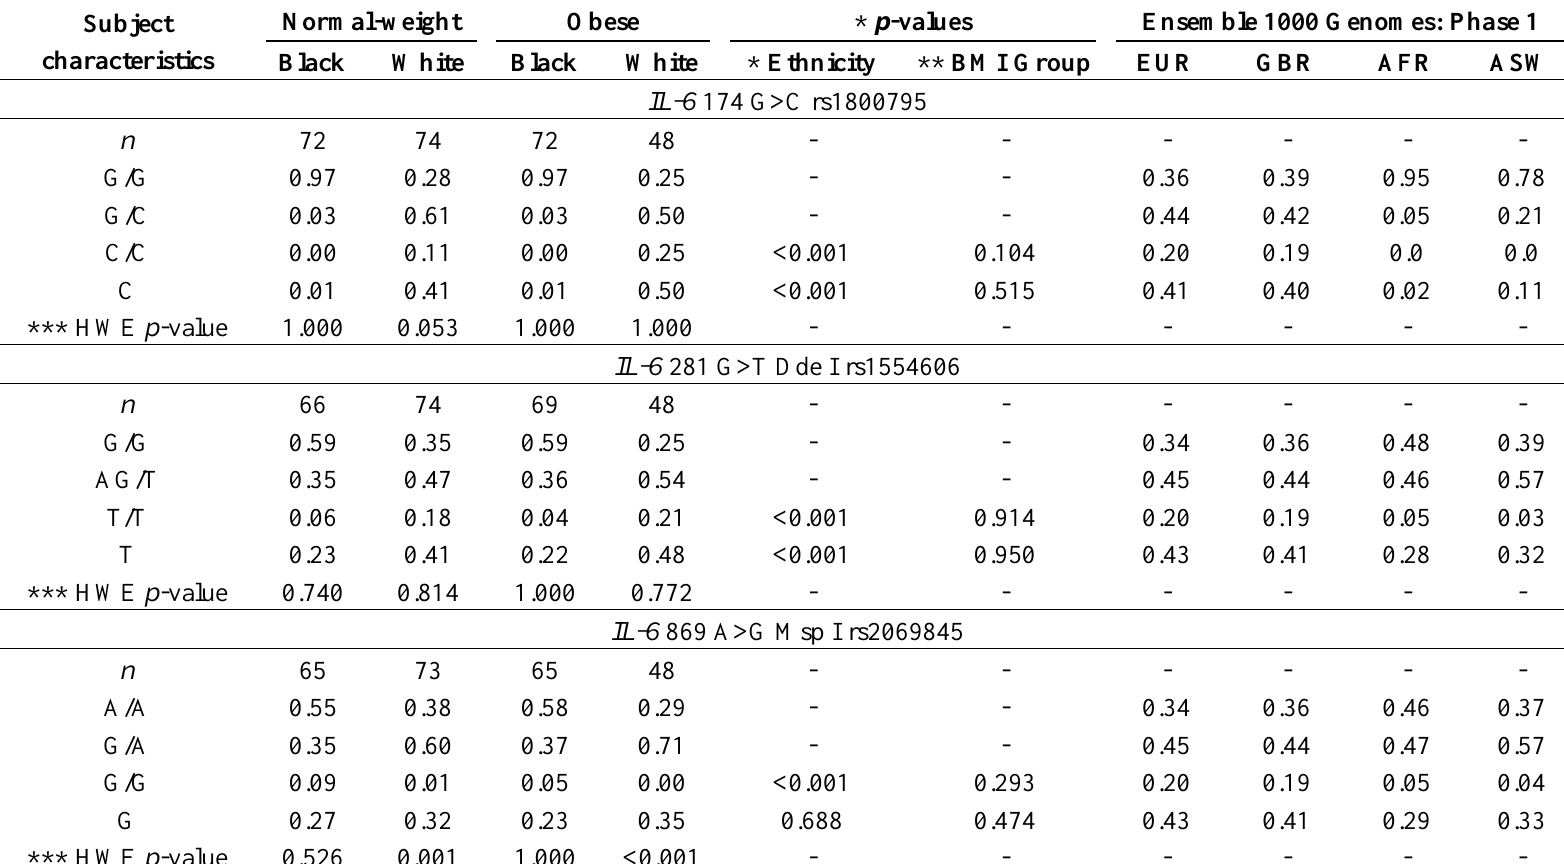
Table 2. Genotype and minor allele frequencies of normal-weight and obese black and white